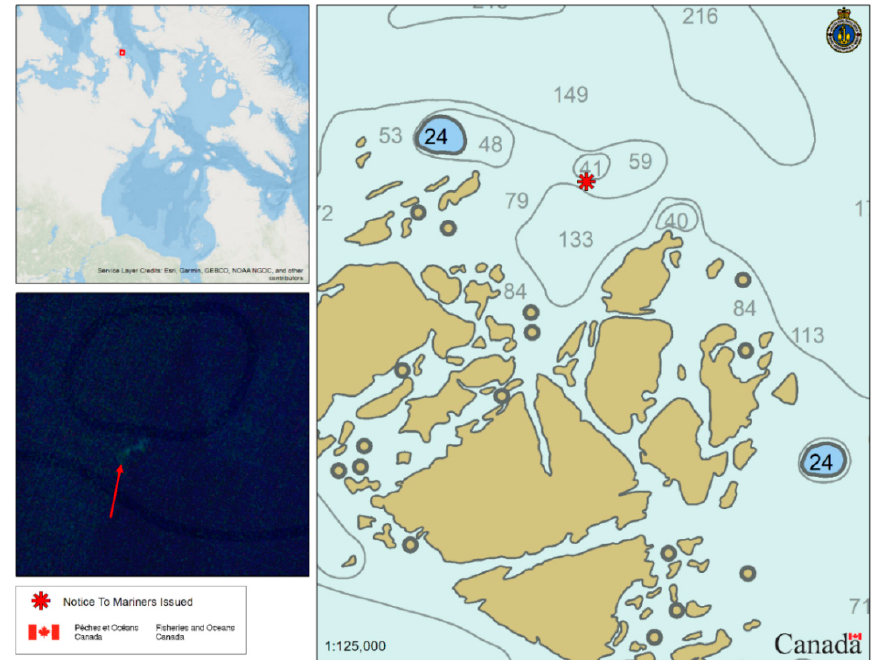
Figure 8. Example of a notice to mariners issued on CHS electronic navigational charts (ENC) (ENC #CA273274).